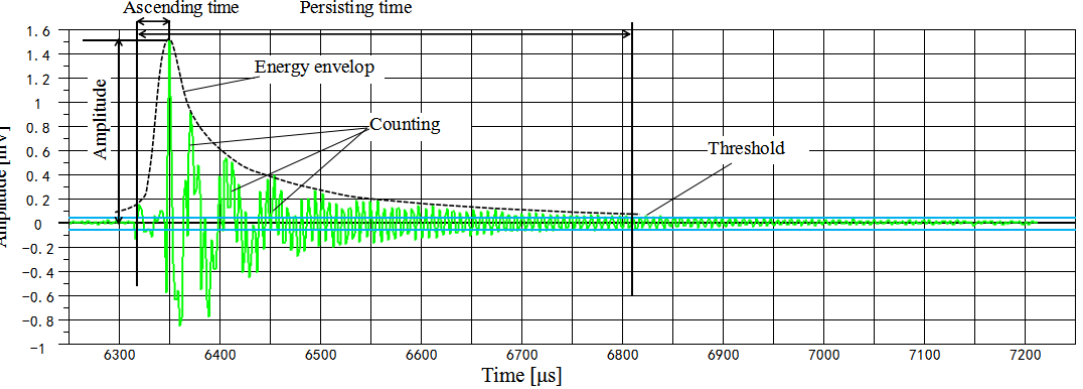
Figure 6. A representative AE waveform.